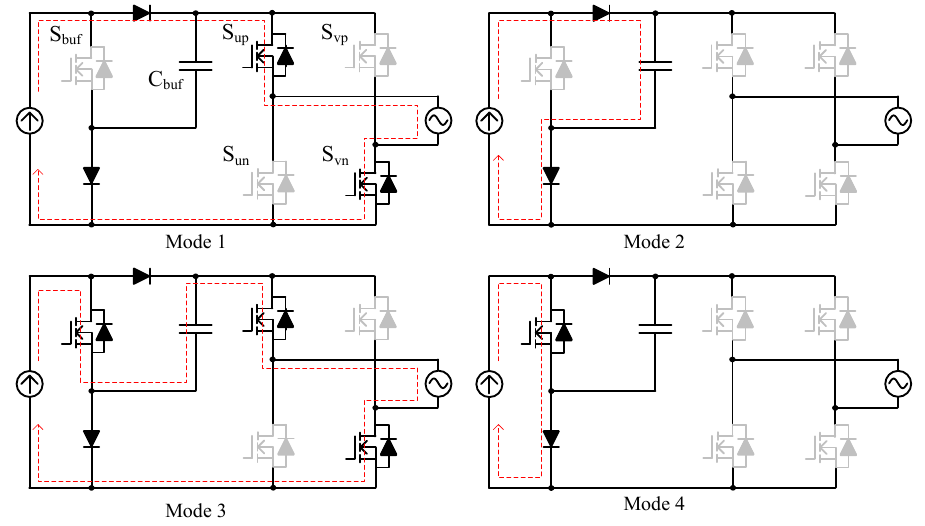
Figure 4. Operation mode of active power decoupling circuit.